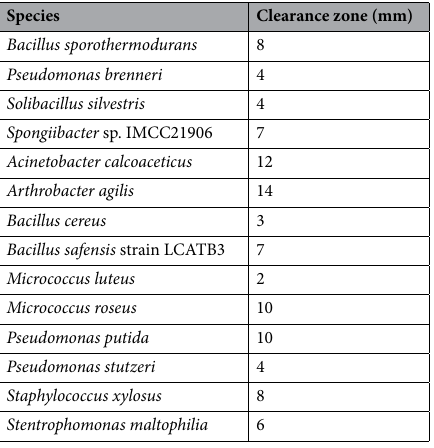
Table 5. Species demonstrating measurable dissolution of agar suspended Calcium carbonate after a period of 15